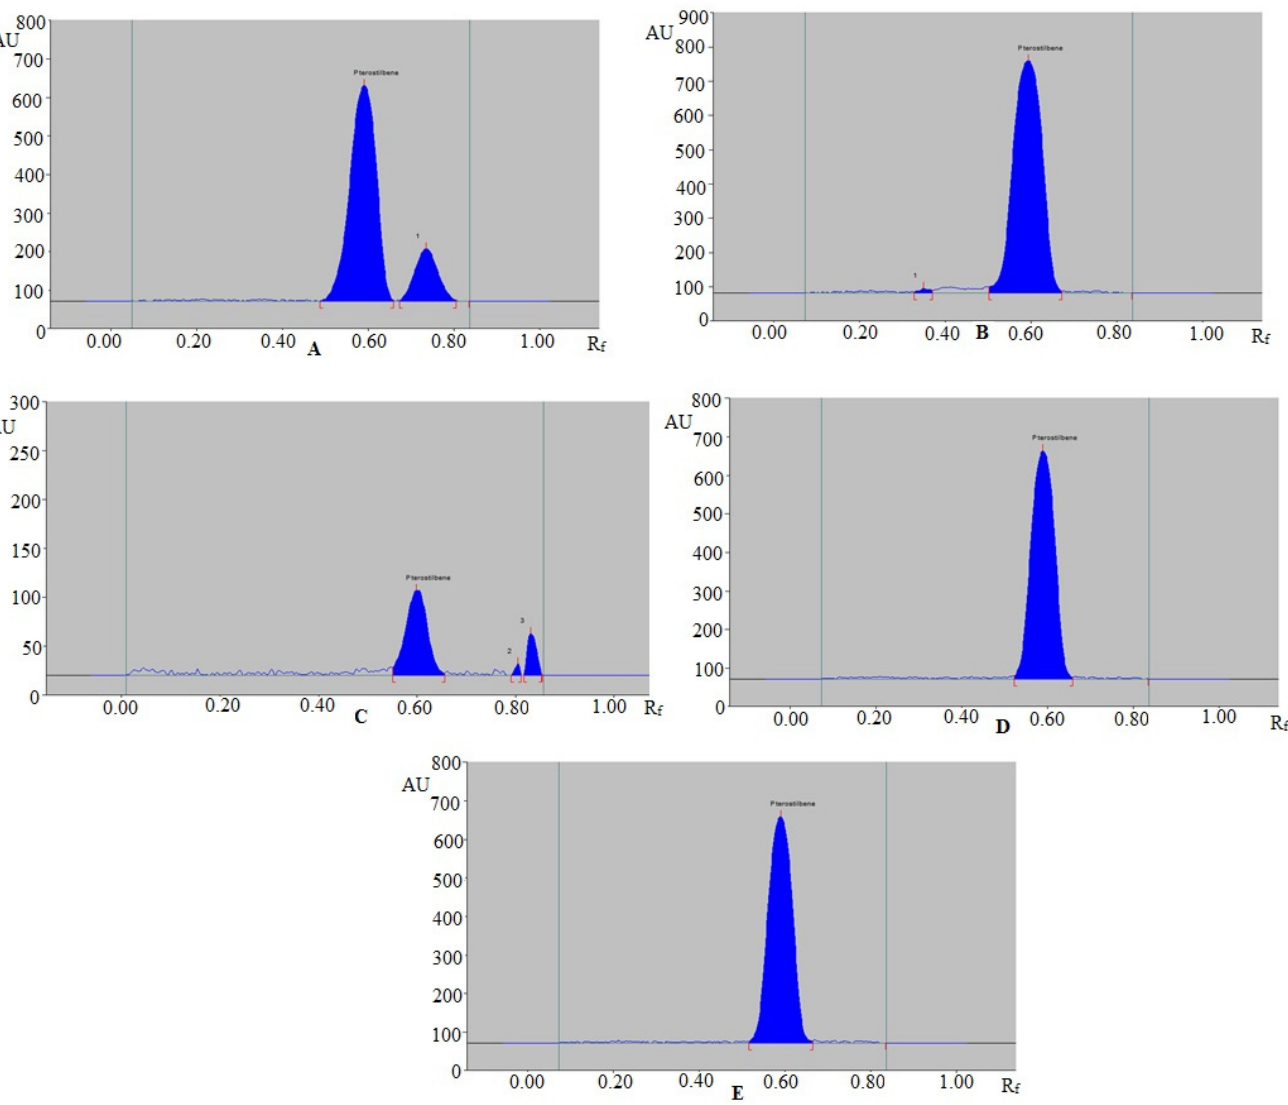
Figure 3. RP-HPTLC chromatograms of PT recorded after ( A ) acid-induced degradation, ( B ) base-induced degradation, ( C ) oxidative degradation, ( D ) thermal degradation, and ( E ) photodegradation of PT using the sustainable RP-HPTLC method.